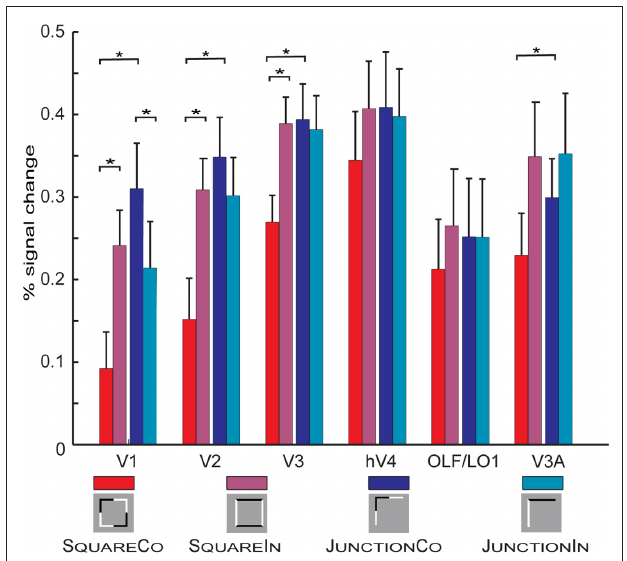
FIguRE 2 | Summarized responses across all retinotopic ROIs and conditions pooled across hemispheres. Error bars depict SE across